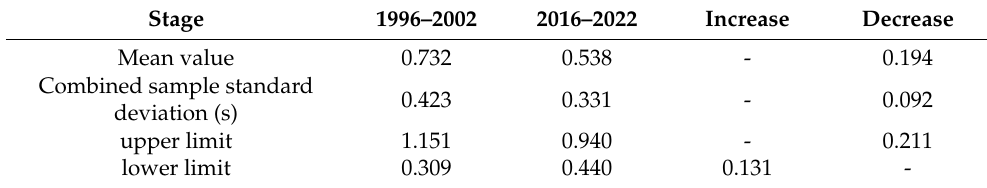
Figure 2. Statistical of pathological score of type III reference product in 2016–2022. N = 12 times. Table 2. Statistics for two stage of type III.